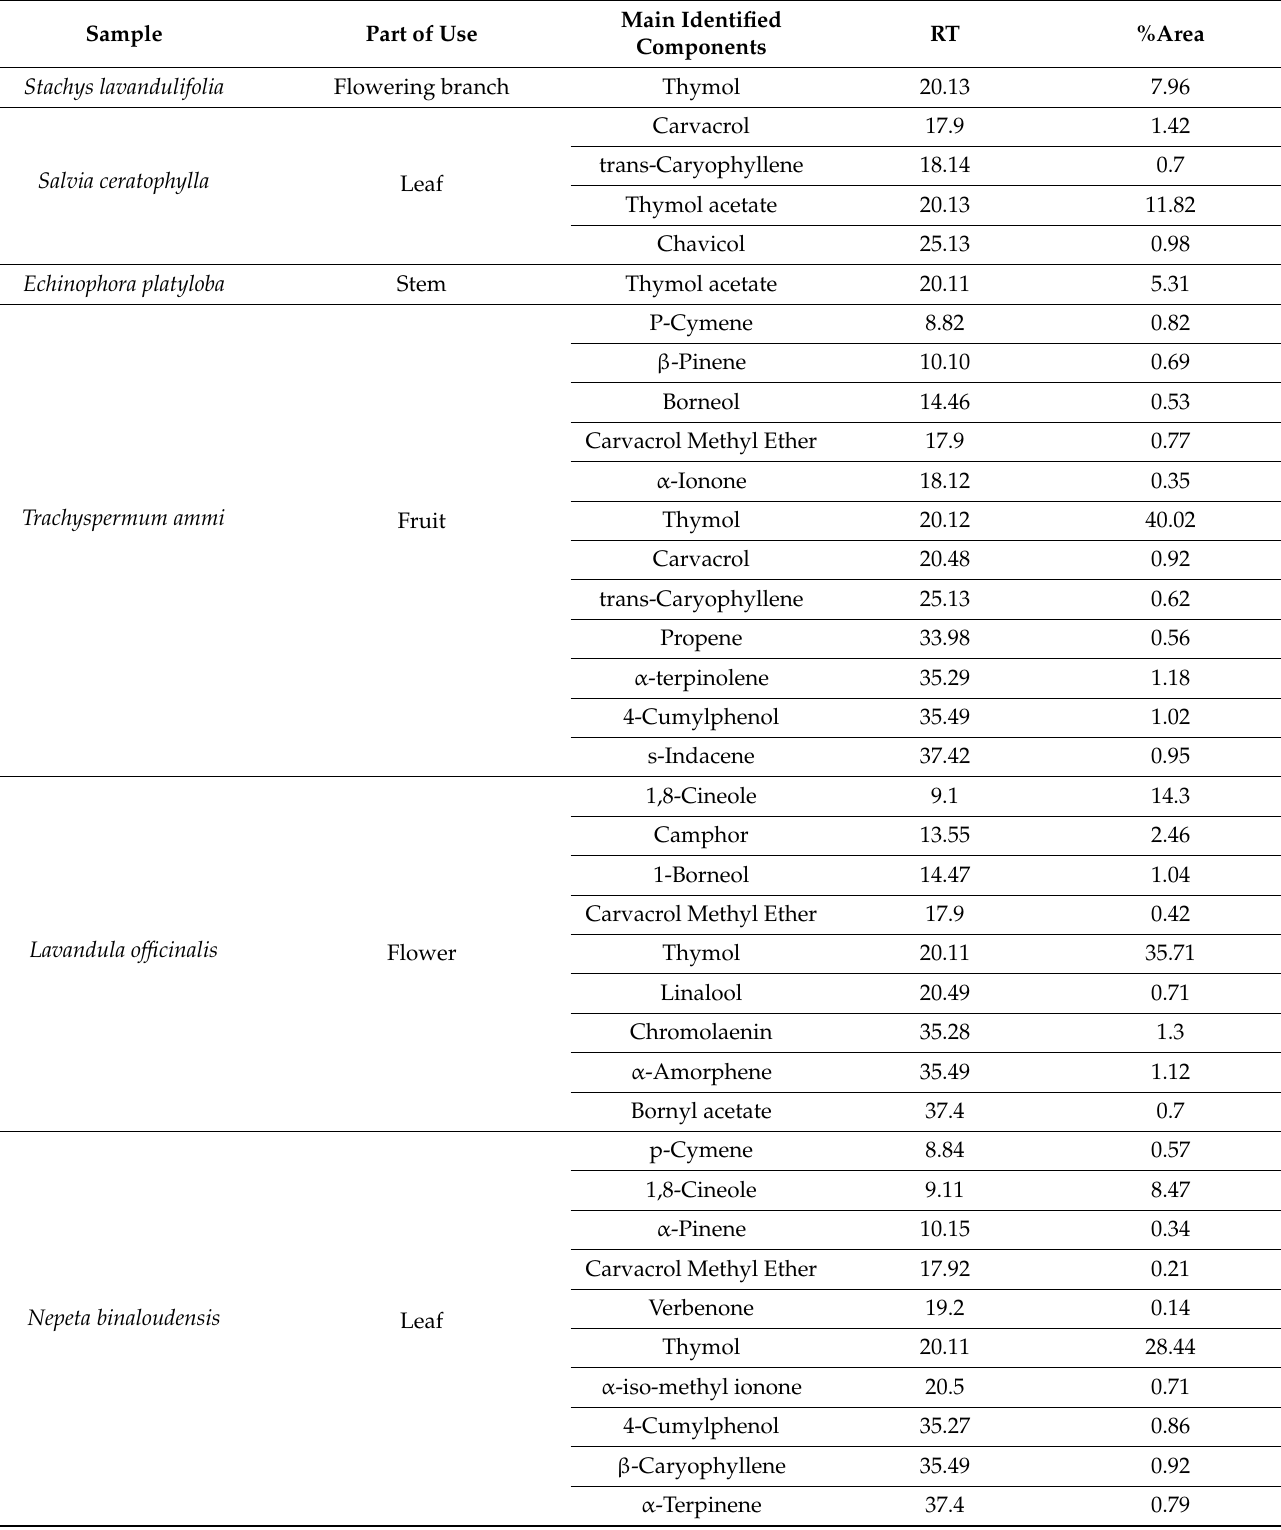
Table 2. The main components of the most inhibitory plants based on Headspace Gas Chromatography- Mass Spectrometry (HS-GC-MS)